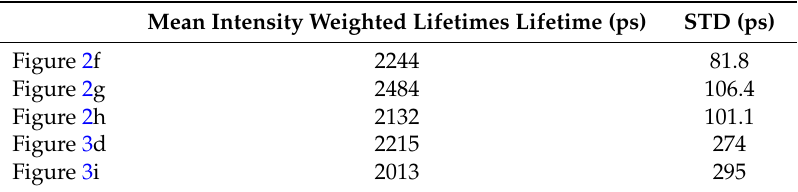
Table 1. Means and standard deviations for the intensity-weighted lifetime histograms of Figures 2 and